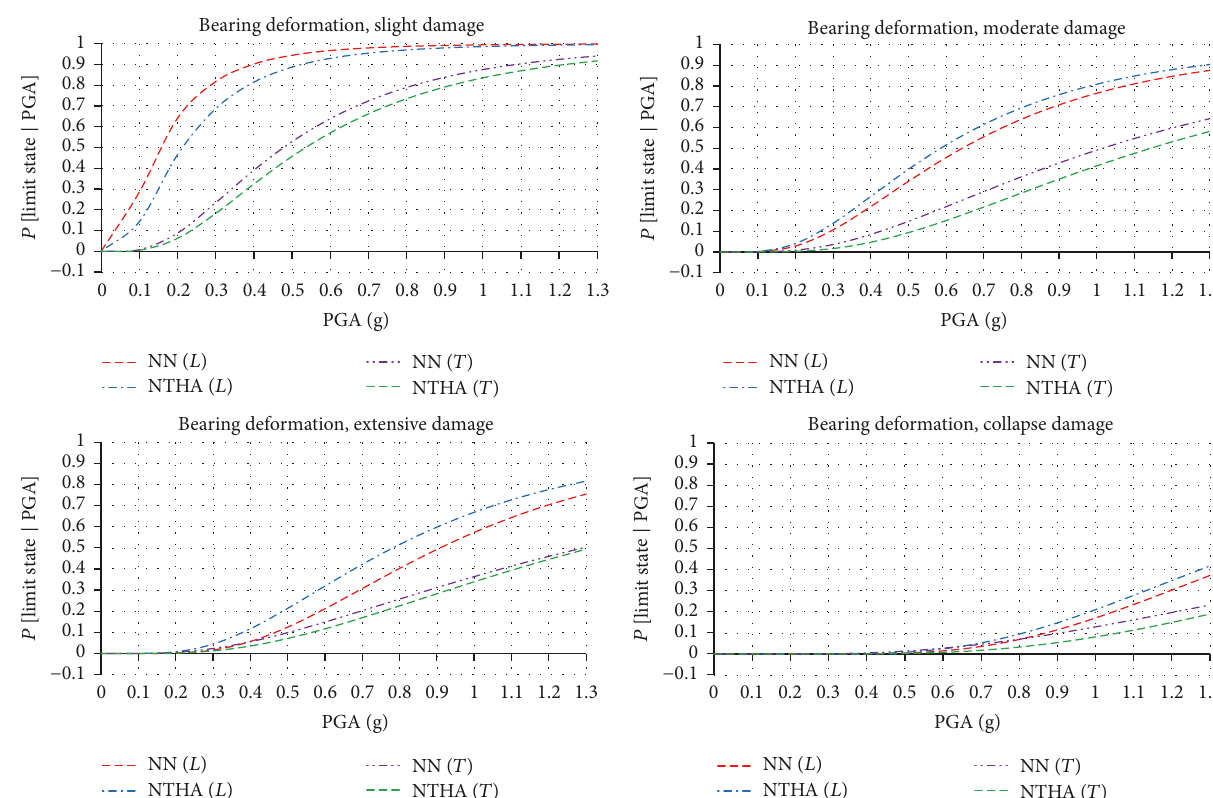
Figure 16: Comparison of the bearing fragility by NN (Approach 2) and NTHA